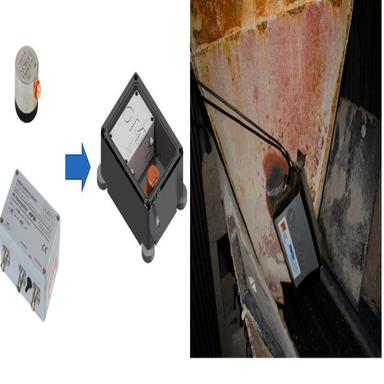
Components (a) and application of the AE sensor in a custom casing at a belt hand-over (b).